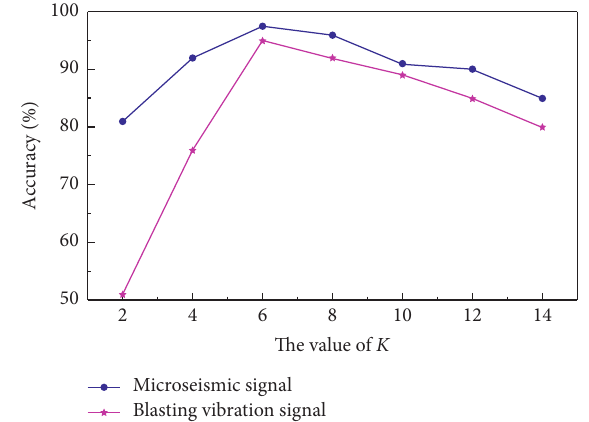
Figure 8: Influences of the K values on the identification